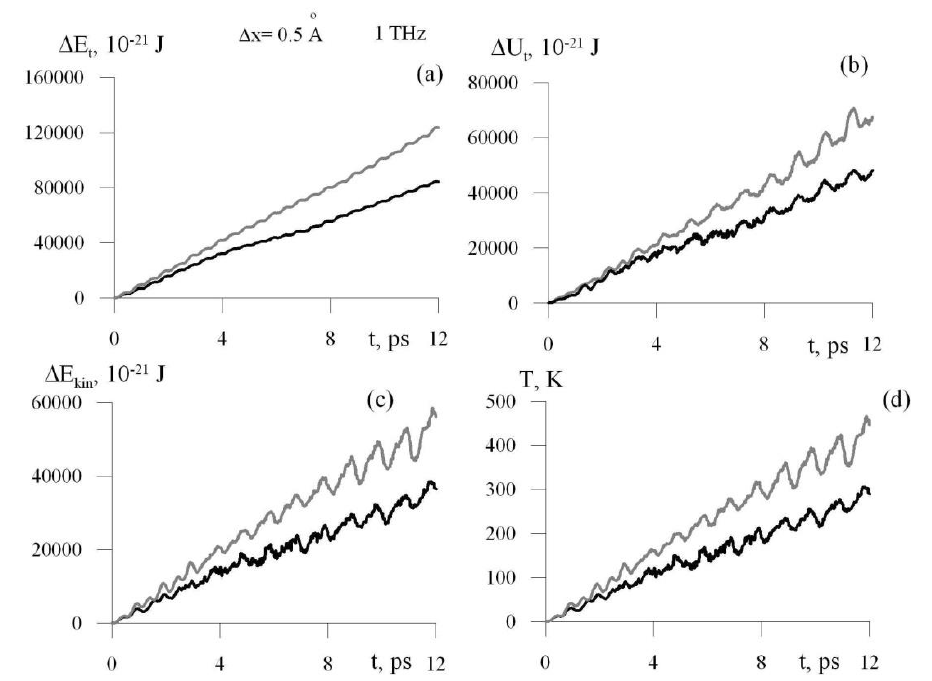
Fig. 8. Time dependence for the energy characteristics of the system under the cyclic loading:  x 0 = 0.5 Å,  =1 THz. (а) – amplification of the total energy of the system; (b) – amplification of the potential energy of atom interaction; (c) – amplification of the thermal energy; (d) – the temperature found via the energy of the thermal chaotic motion of atoms. Black line – perfect nanorod; grey line – amorphized